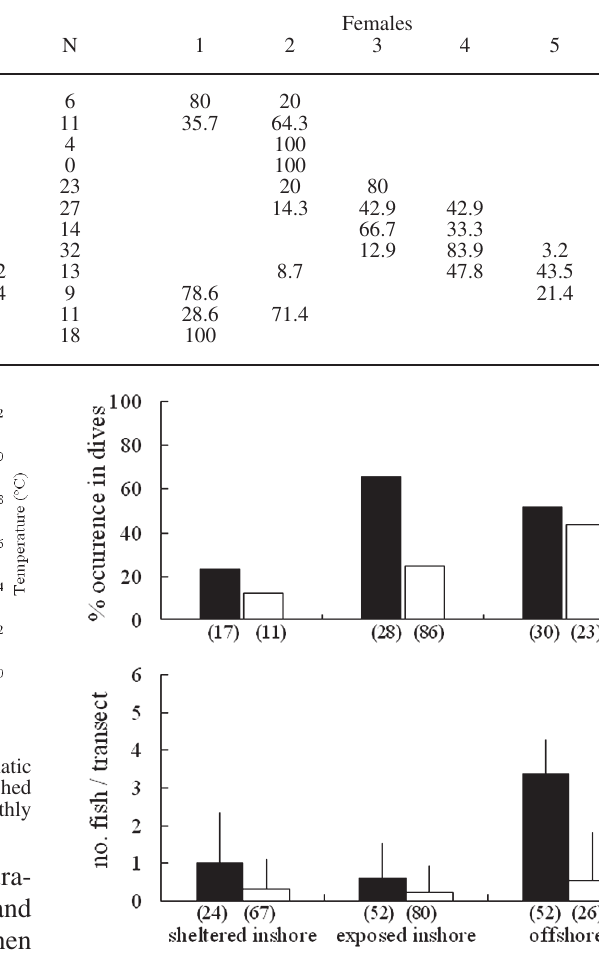
Fig . 5. – differences between islands in the occurrence of white trevally in summer according to the type of reef habitat surveyed, measured by: a) relative frequency of occurrence in dives; b) total abundance per transect (x ± se); black bars = corvo island, white bars = faial island. sample sizes (number of dives and transects, respectively) are given in